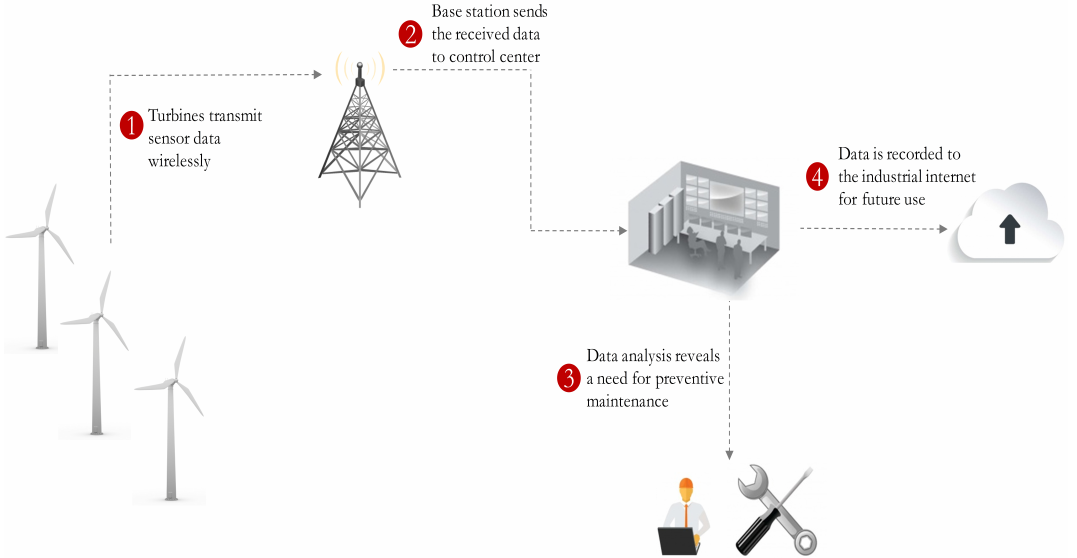
Figure 1. Use of Internet of Things (IoT) network for transmitting data from turbines to control center and